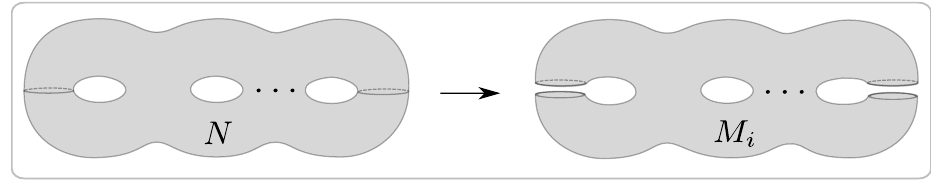
Figure 4. Example of a decomposition of M